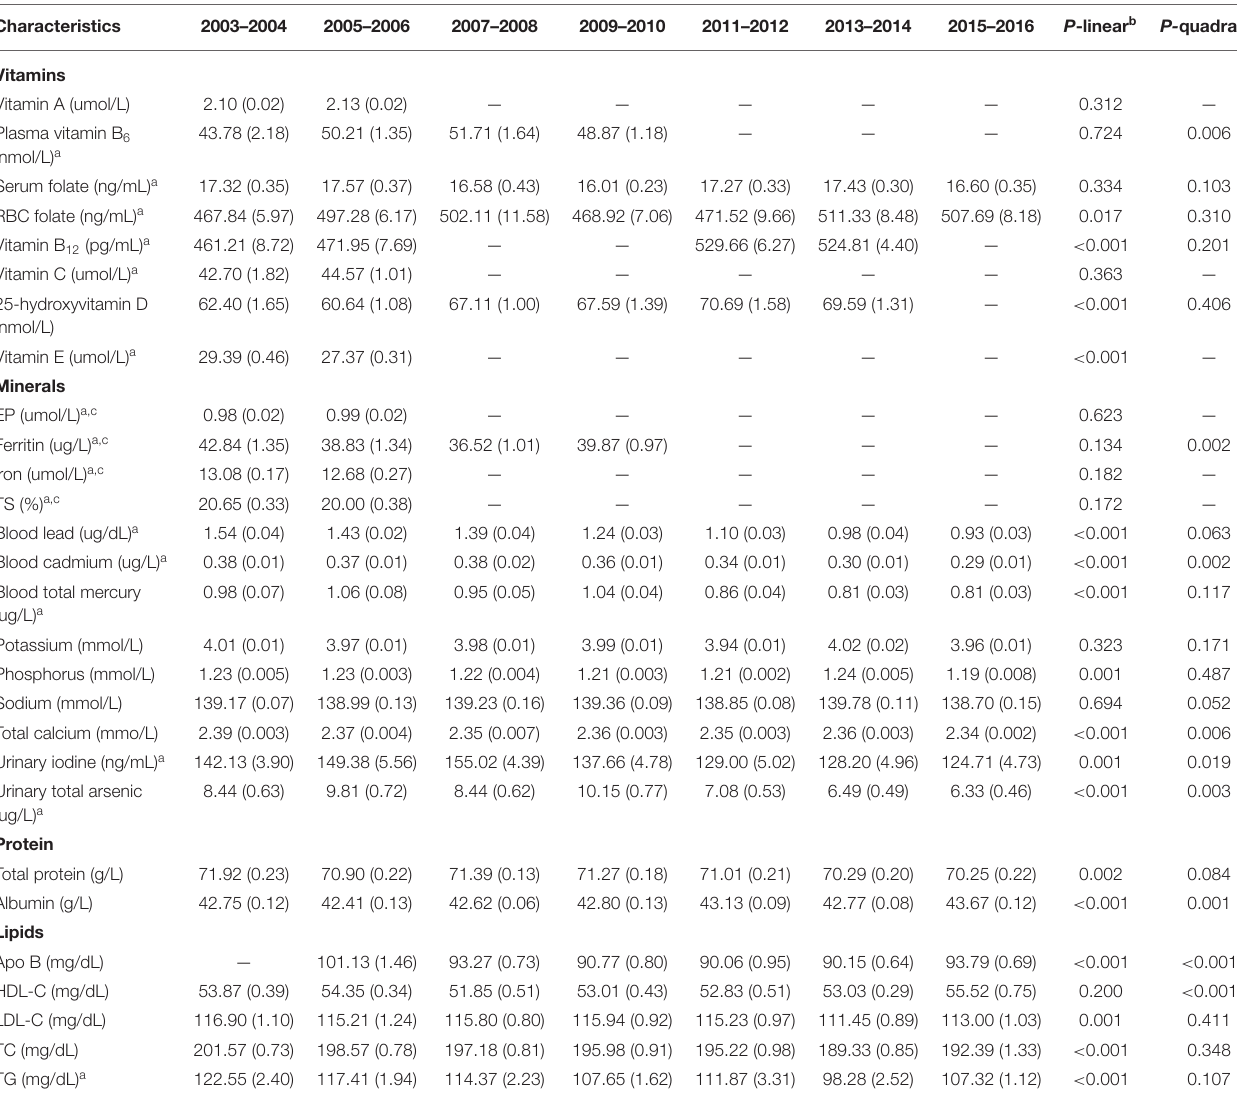
TABLE 2 | Trends of nutritional biomarkers among US adults in the National Health and Nutrition Examination Survey